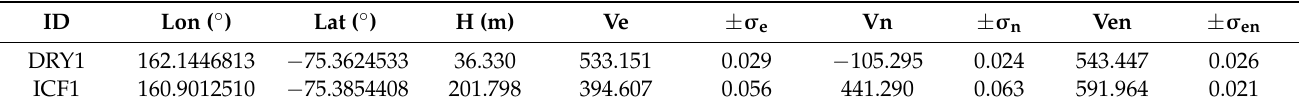
Table 1. Estimated coordinates and horizontal velocities of GNSS stations. Velocities and errors are in m/yr.